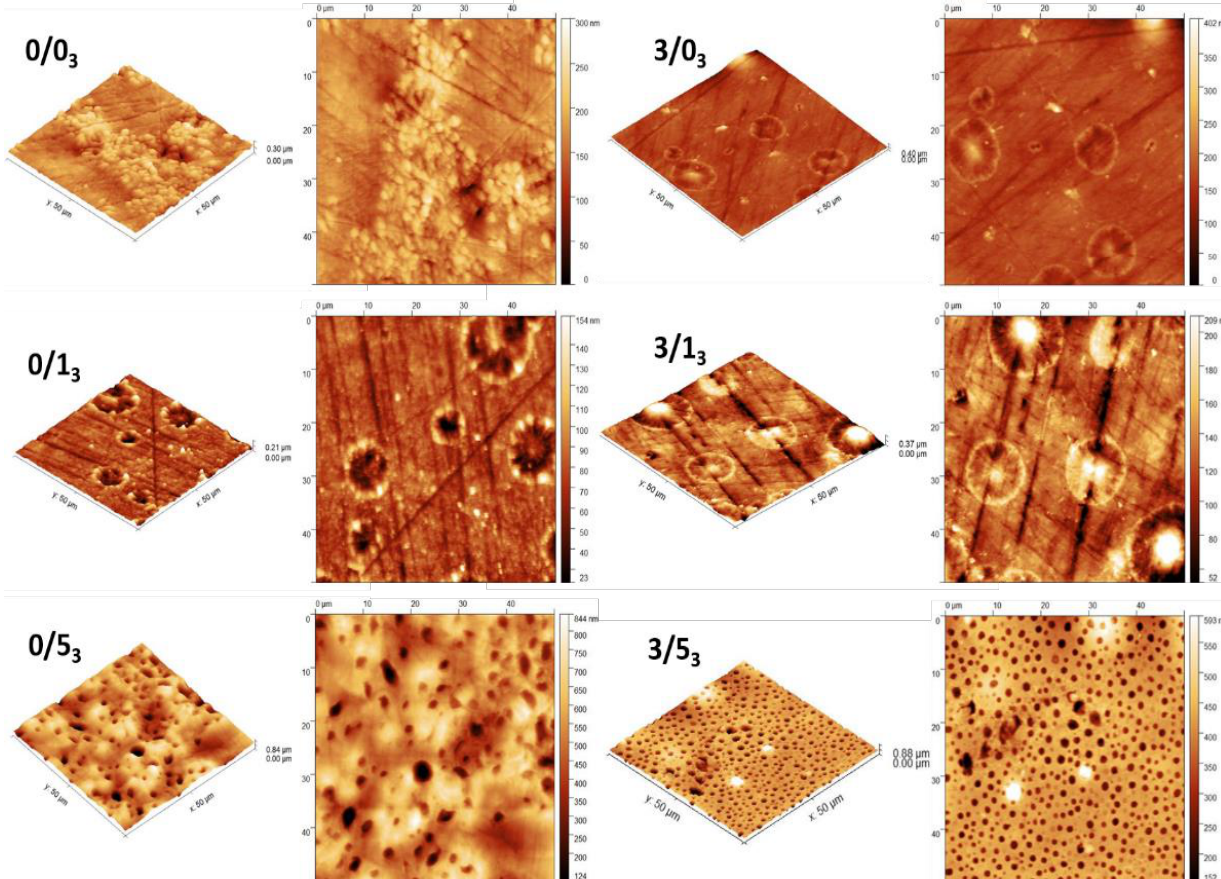
Figure 4. AFM images of films non-magnesium-containing and magnesium-containing and with CTAB after degradation for 3 months. For each kind of sample, left and right images are topographical and deflection images, respectively.